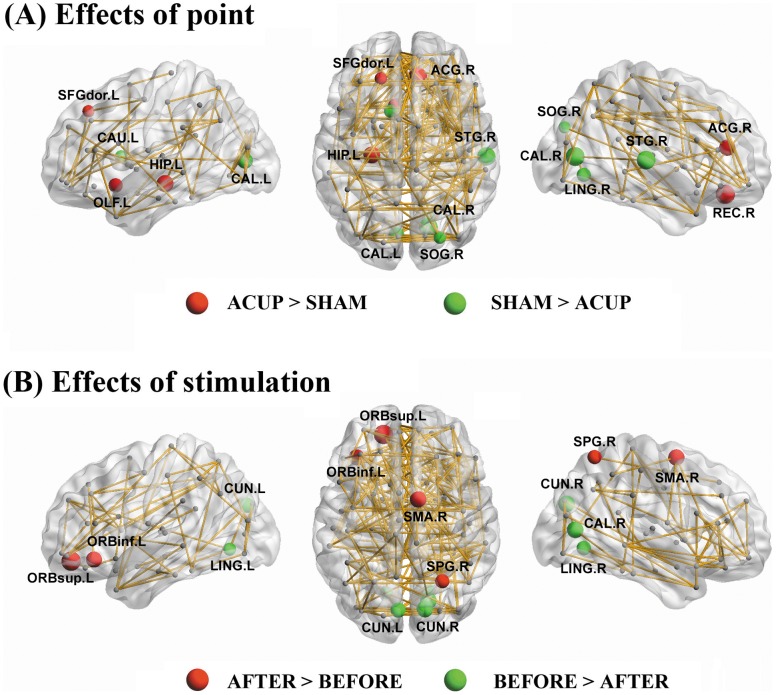
Regions showing significant point- (A) and stimulation- (B) related differences in regional nodal degree.The node sizes indicate the effects (i.e., t values) of interest on nodal degree. The threshold was P<0.05 (uncorrected). Note that the connectivity backbone (sparsity  = 5%) was obtained by thresholding the mean correlation matrix across all subjects and conditions. For more details, see Table 3. ACUP, acupuncture at ST36; SHAM, acupuncture at sham point; Before, before stimulation; After, after stimulation; L, left; R, right.